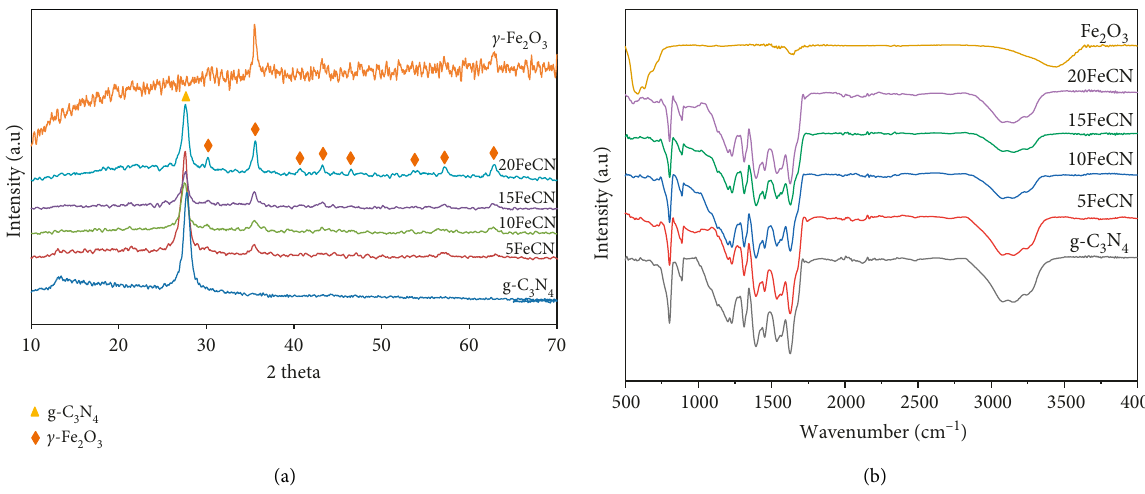
Figure 2: XRD patterns (a) and FTIR (b) spectra of g-C